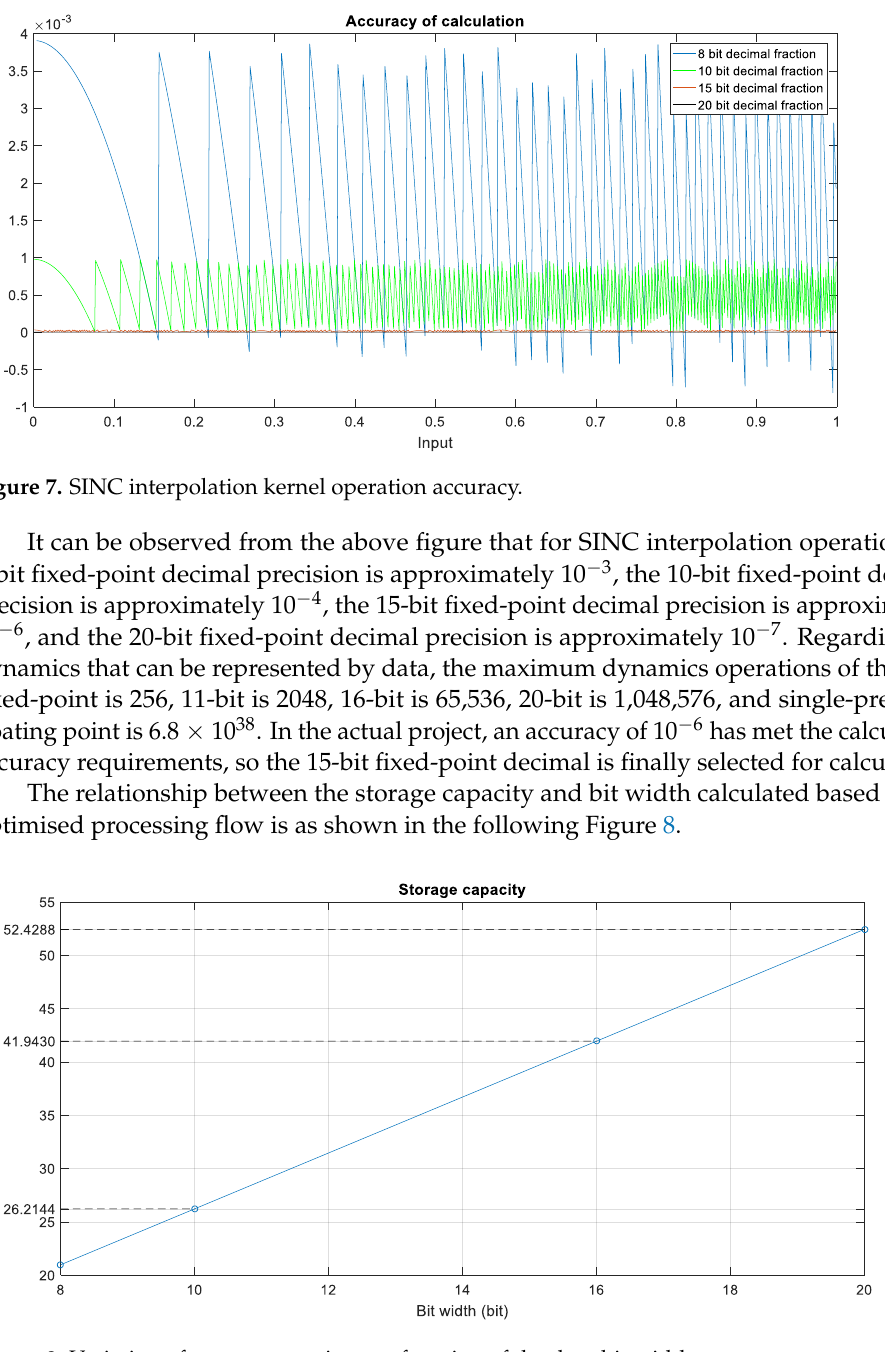
Table 2. Impact of bit width on processing resources.